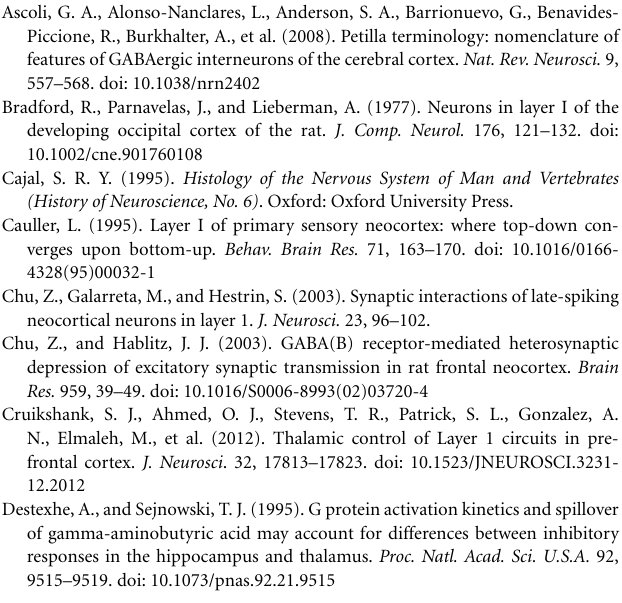
GABA B and (D) for cells with both GABA A + B